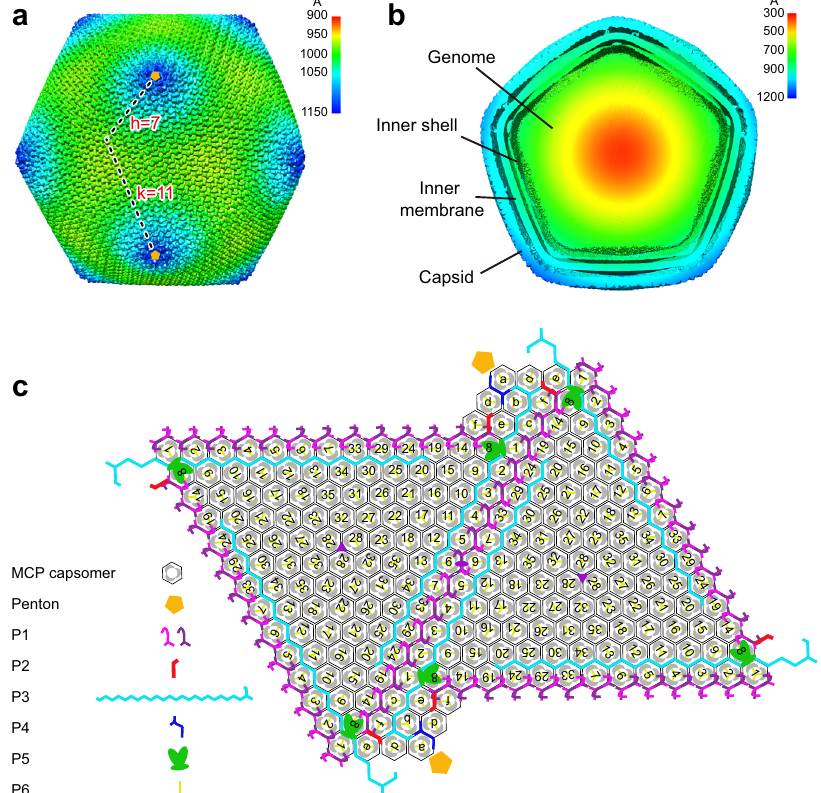
Fig. 1 | Overall architecture of SGIV capsid. a Icosahedrally averaged cryo-EM reconstruction of the viral capsid, which is colored by the radial distance from the virus center. h and k vectors constituting the T number are shown as dashed lines. The pentamericcapsomers(penton)are presentedassolidorangepentagons,and each penton proteinoccupies a vertex of a pentagon. b Density mapsliceshowing multiple layers of the SGIV virion, which is colored by the radial distance from the virus center. c Diagrammatic organization of the MCP trimer and mCPs viewed